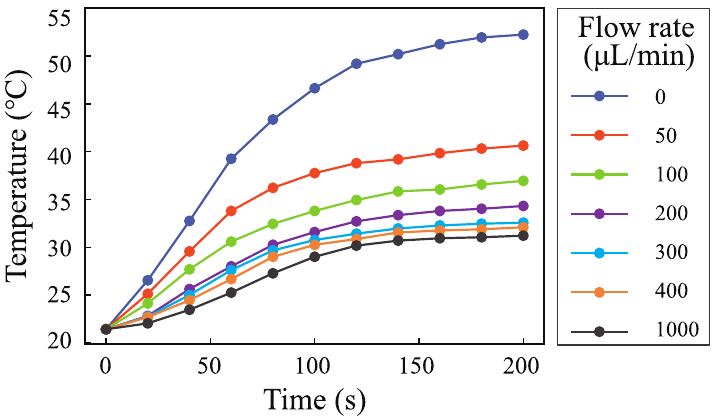
Figure 6. Fluid temperature changing with time when the input voltages are 0.3 V, 0.4 V, 0.5 V, 0.6 V, 0.7 V, and 0.8 V.